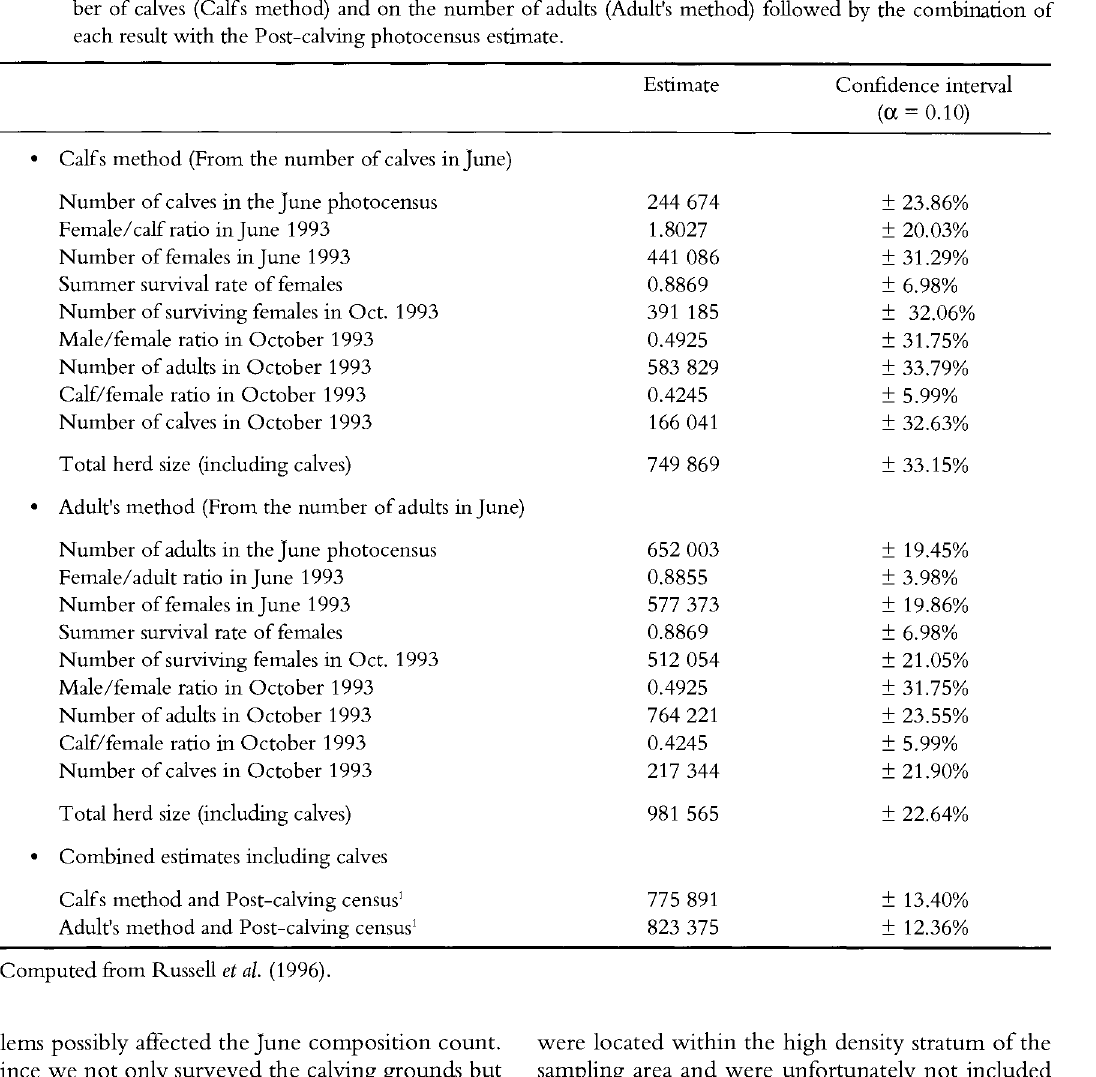
Table 5. Herd size calculation for the June 1993 photocensus of the Riviere George Caribou Herd, based on the num ber of calves (Calf s method) and on the number of adults (Adult's method) followed by the combination of each result with the Post-calving photocensus